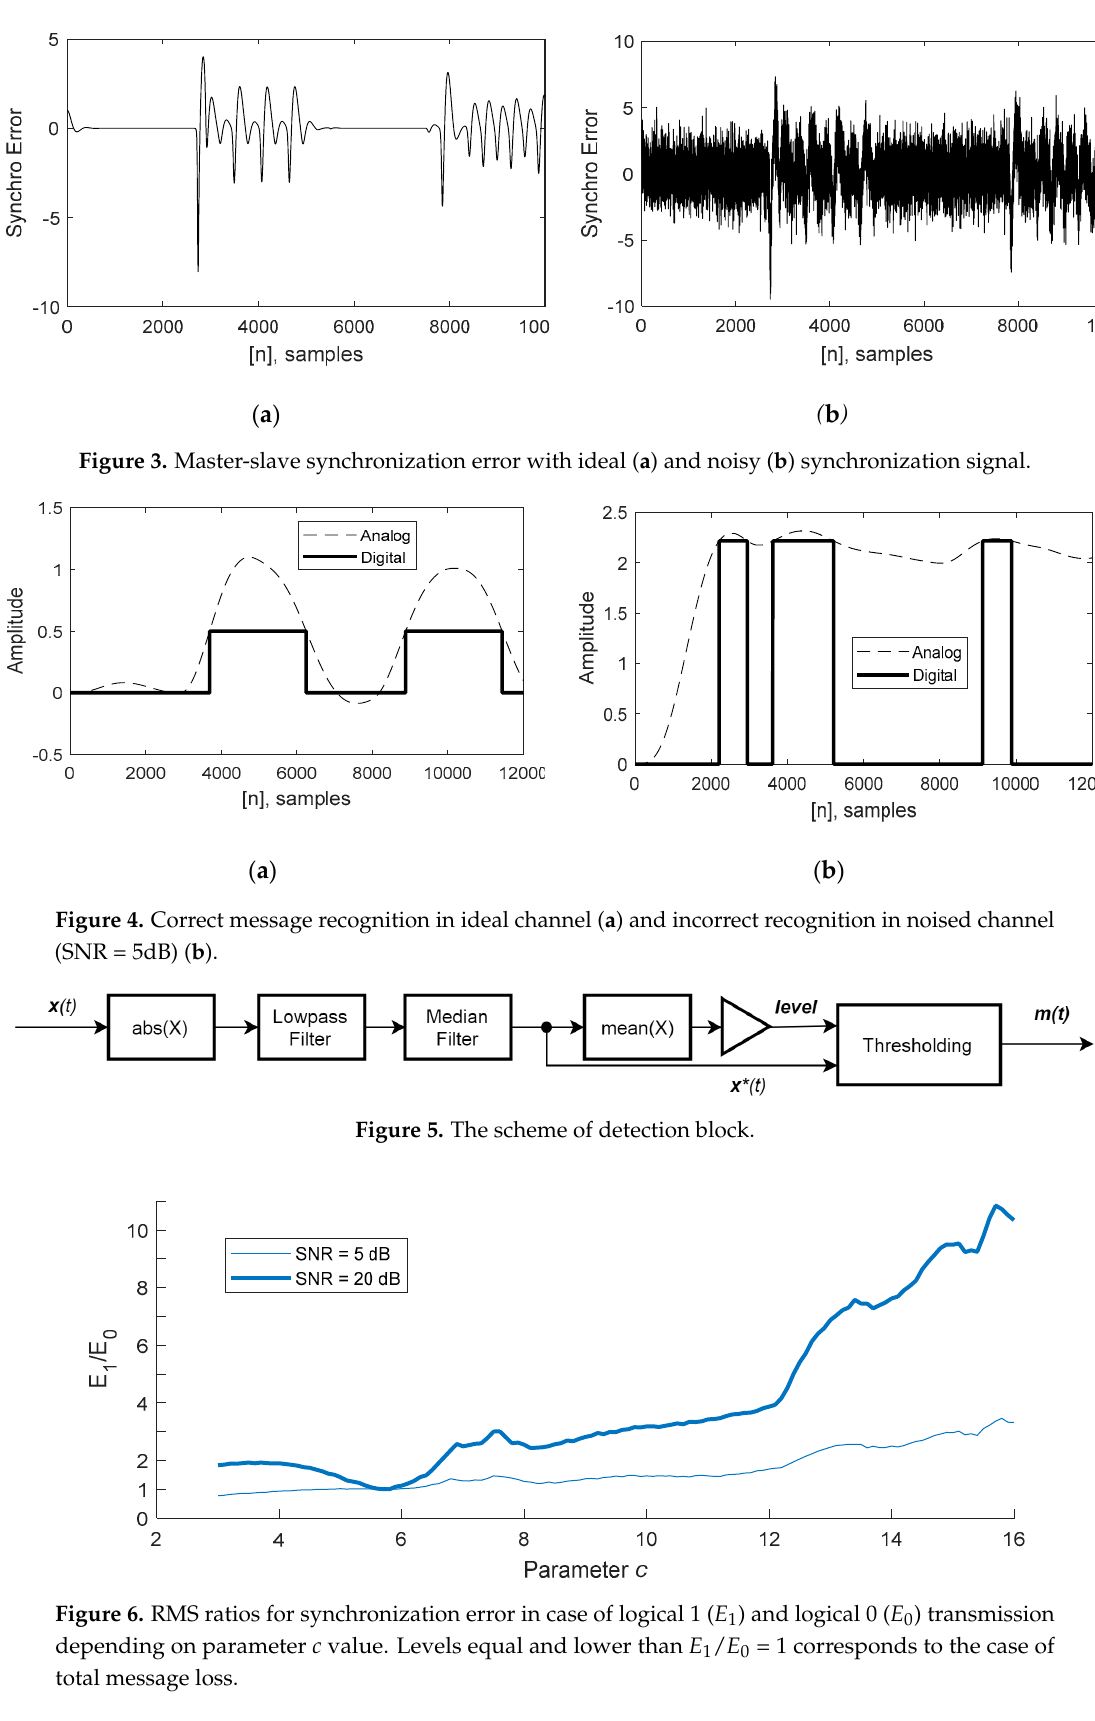
Figure 3. Master-slave synchronization error with ideal ( a ) and noisy ( b ) synchronization signal.